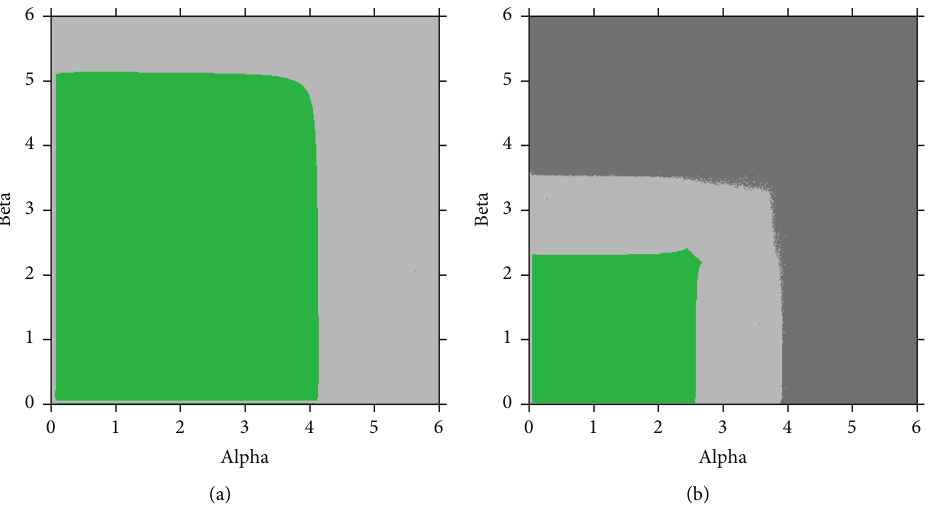
Figure 11: The stable region of both bargaining systems.